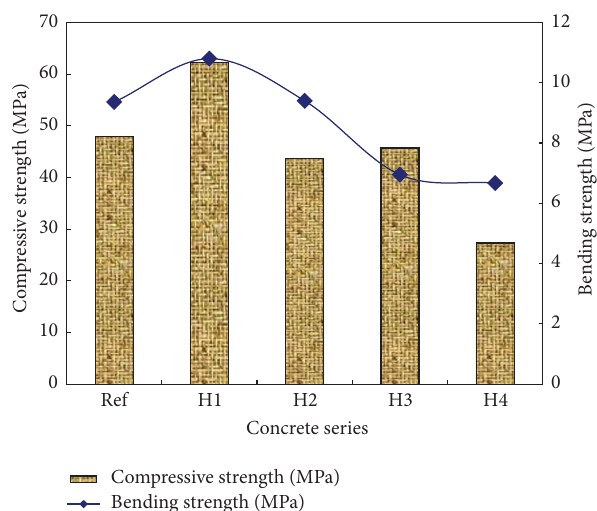
Figure 2: Test results of concrete strengths at hydration age of 56 days.